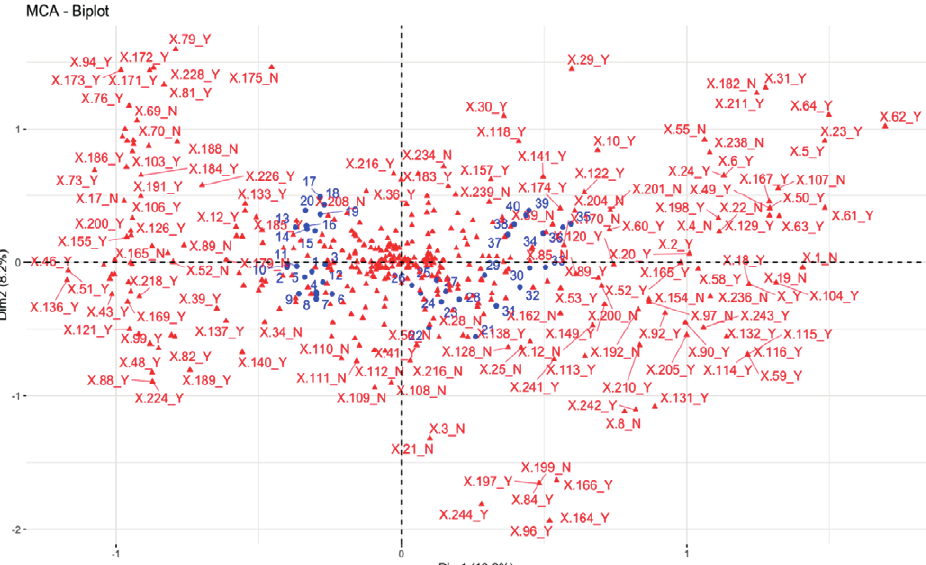
Figure 6. MCA-biplot based on alleles studied. Red numbers : alleles (Y=presence and N=absence), blue number: date palm trees